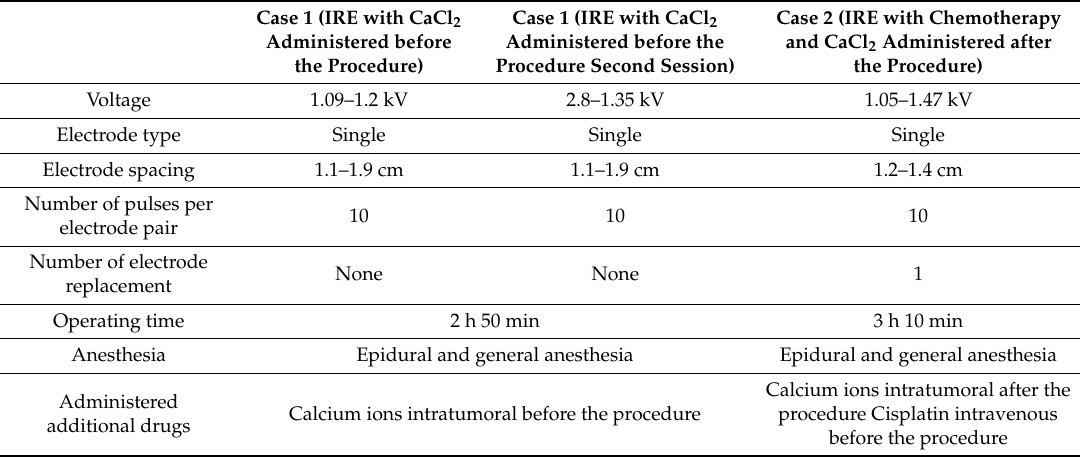
Table 2. Electroporation protocols, anesthesia, and additional drug data.